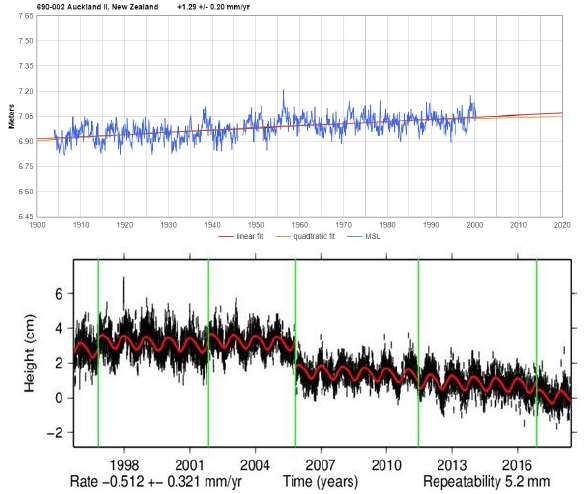
Figure 6: MSL (top) and GPS (bottom) data for Auckland II. Images reproduced and modified after http://www.sealevel.info/ and JPL